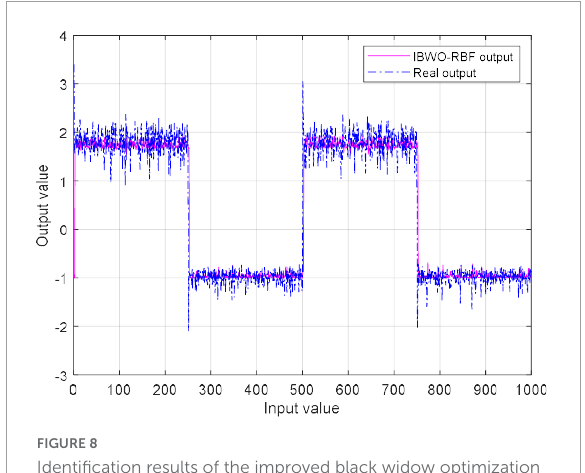
FIGURE8 Identification results of the improved black widow optimization algorithm (IBWO)-RBF model.